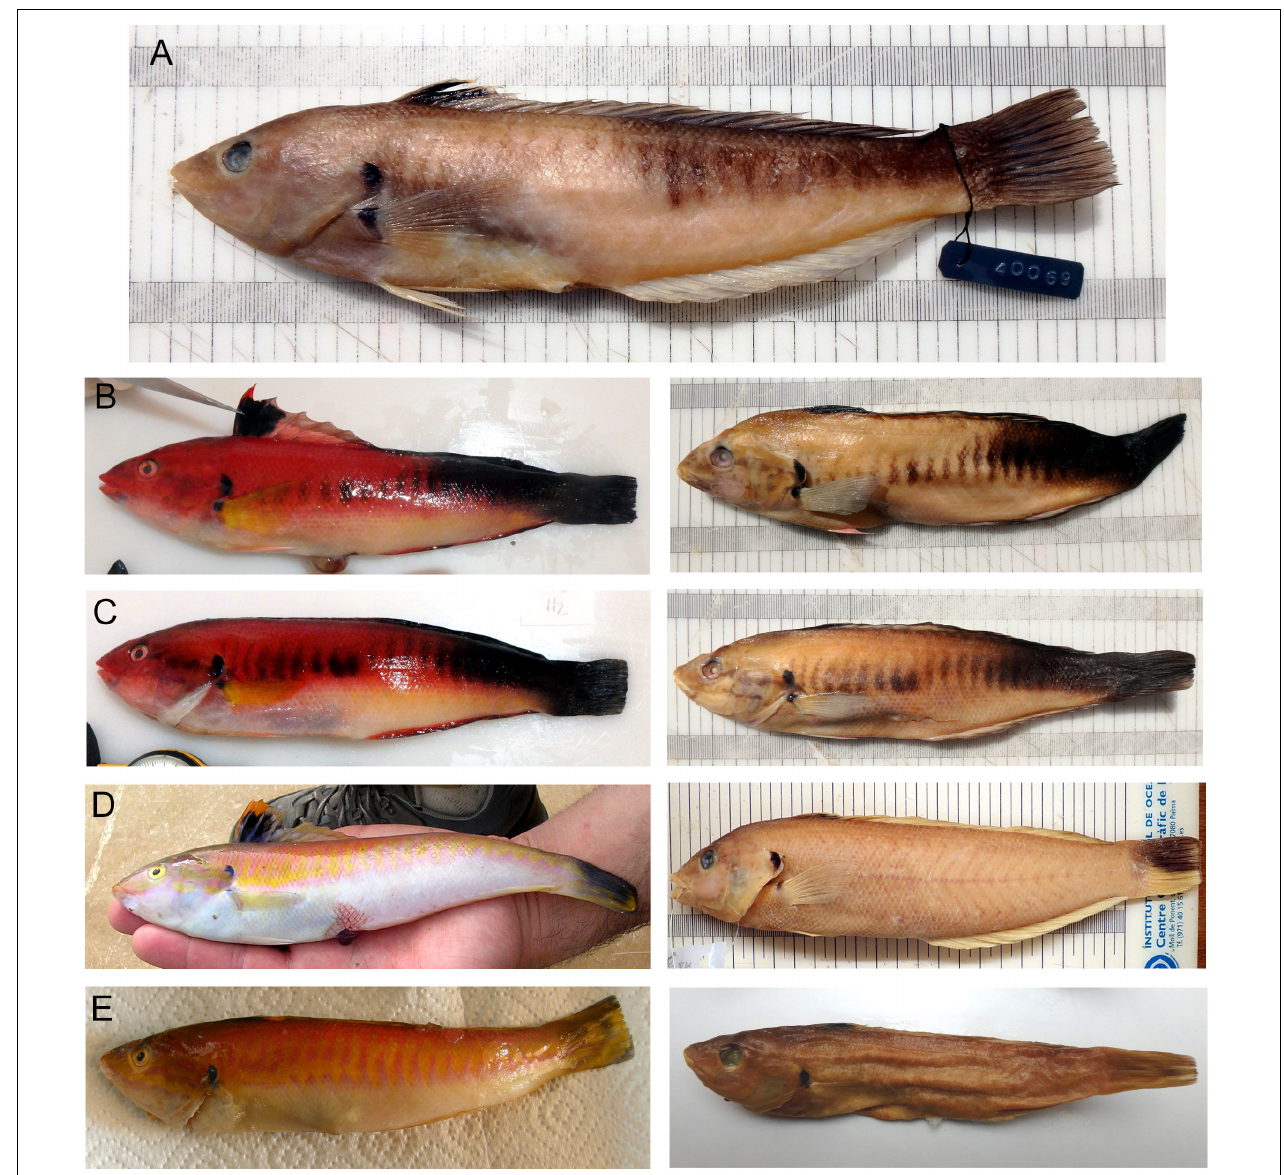
FIGURE 3 | Photographs of fresh and preserved neotype and other material of Coris melanura showing the secondary livery (males). (A) Neotype MFF 40069 from Madeira, Atlantic Ocean; (B,C) other material CFM-IEOMA7428 and CFM-7427 from Santander, Bay of Biscay, Atlantic Ocean, respectively; (D,E) other material MNIB 177 and MNIB 182 from Mallorca and Ibiza, Balearic Islands, Mediterranean Sea, respectively. The fresh and preservation in formalin color are disposed in right and left site, respectively.